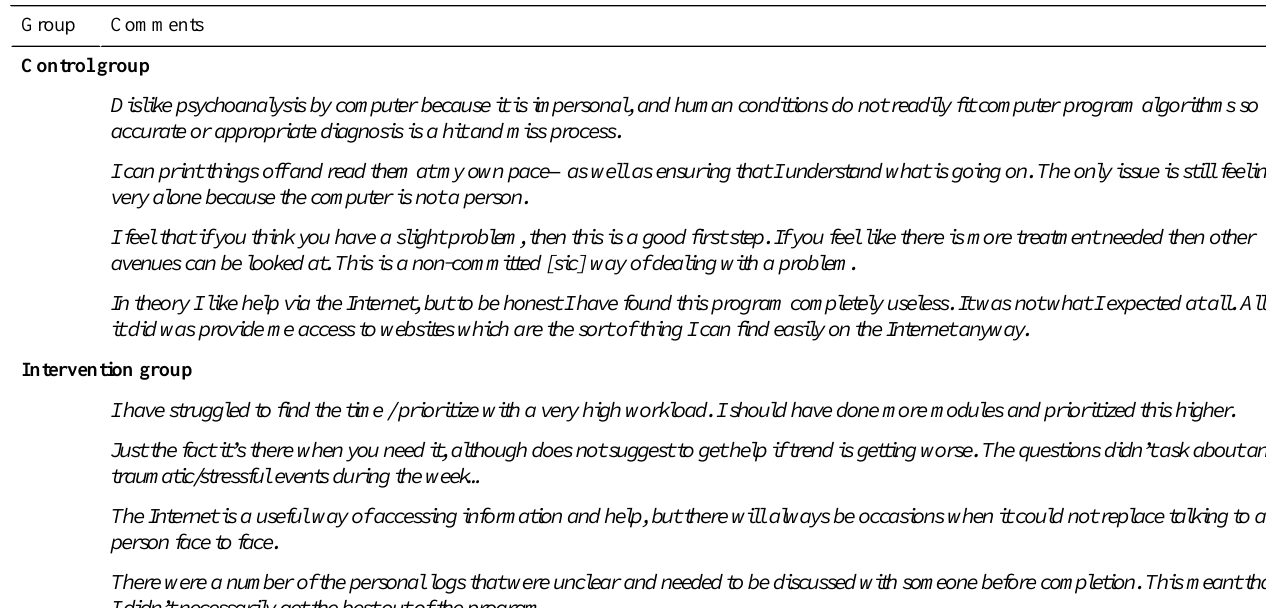
Table 3. Representative comments from control and intervention group